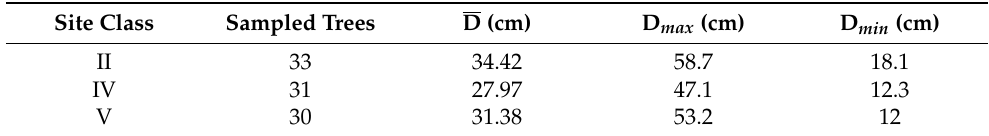
Table 2. Sampled information of Larix olgensis .